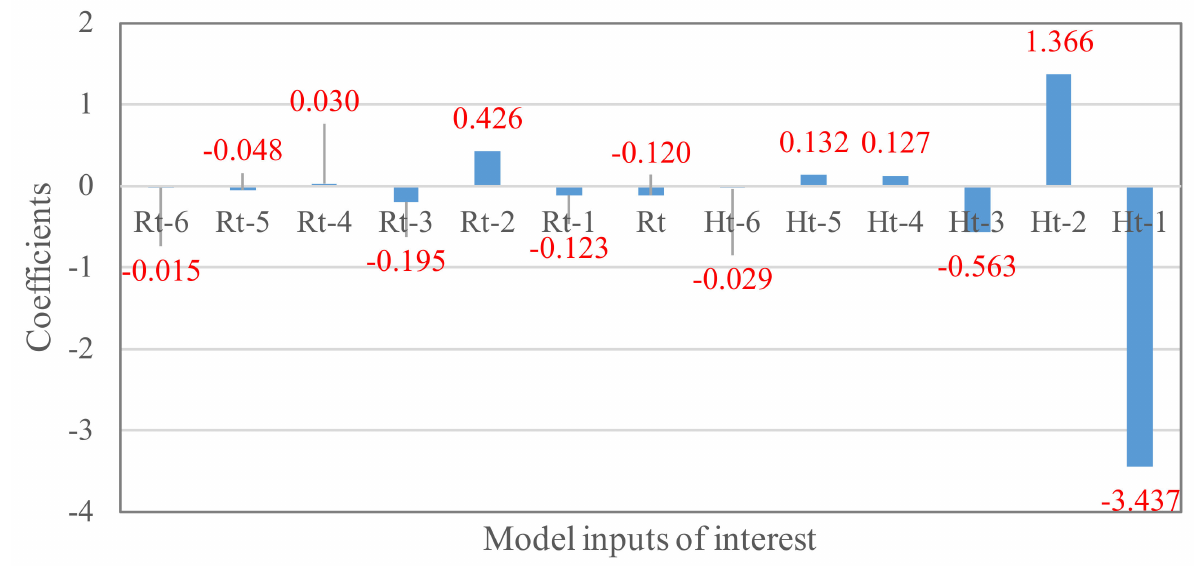
Figure 10. The averages of absolute sensitivity coefficients regarding the areal average rainfall and inundation depths at the various forward time